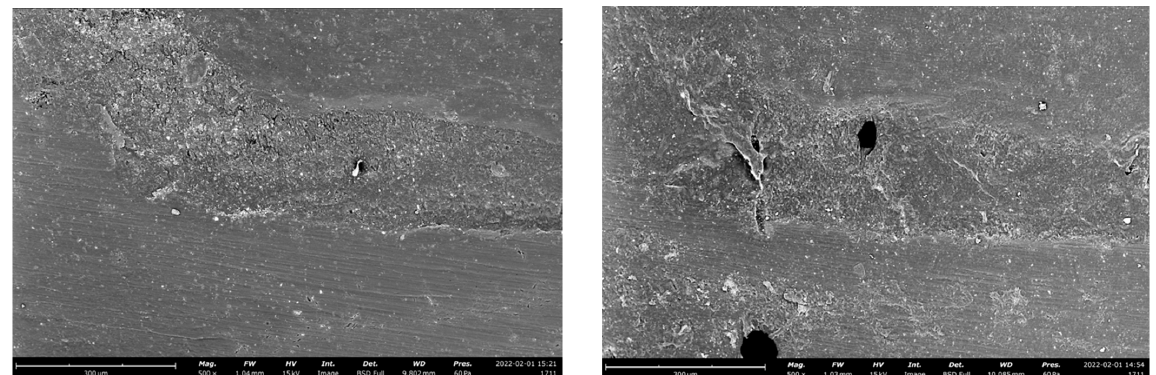
Figure 2. Representative SEM images of the adhesive interface of an adhesive crown before ( left ) and after ( right ) the chewing simulation test, restored with PICN.